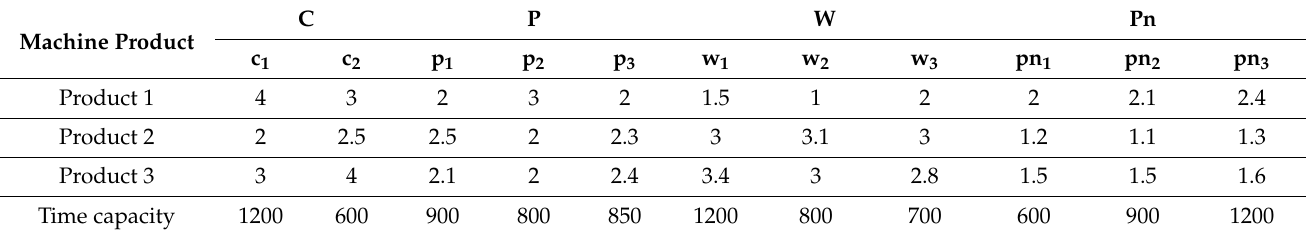
Table 14. Process time of each of the services for the case study